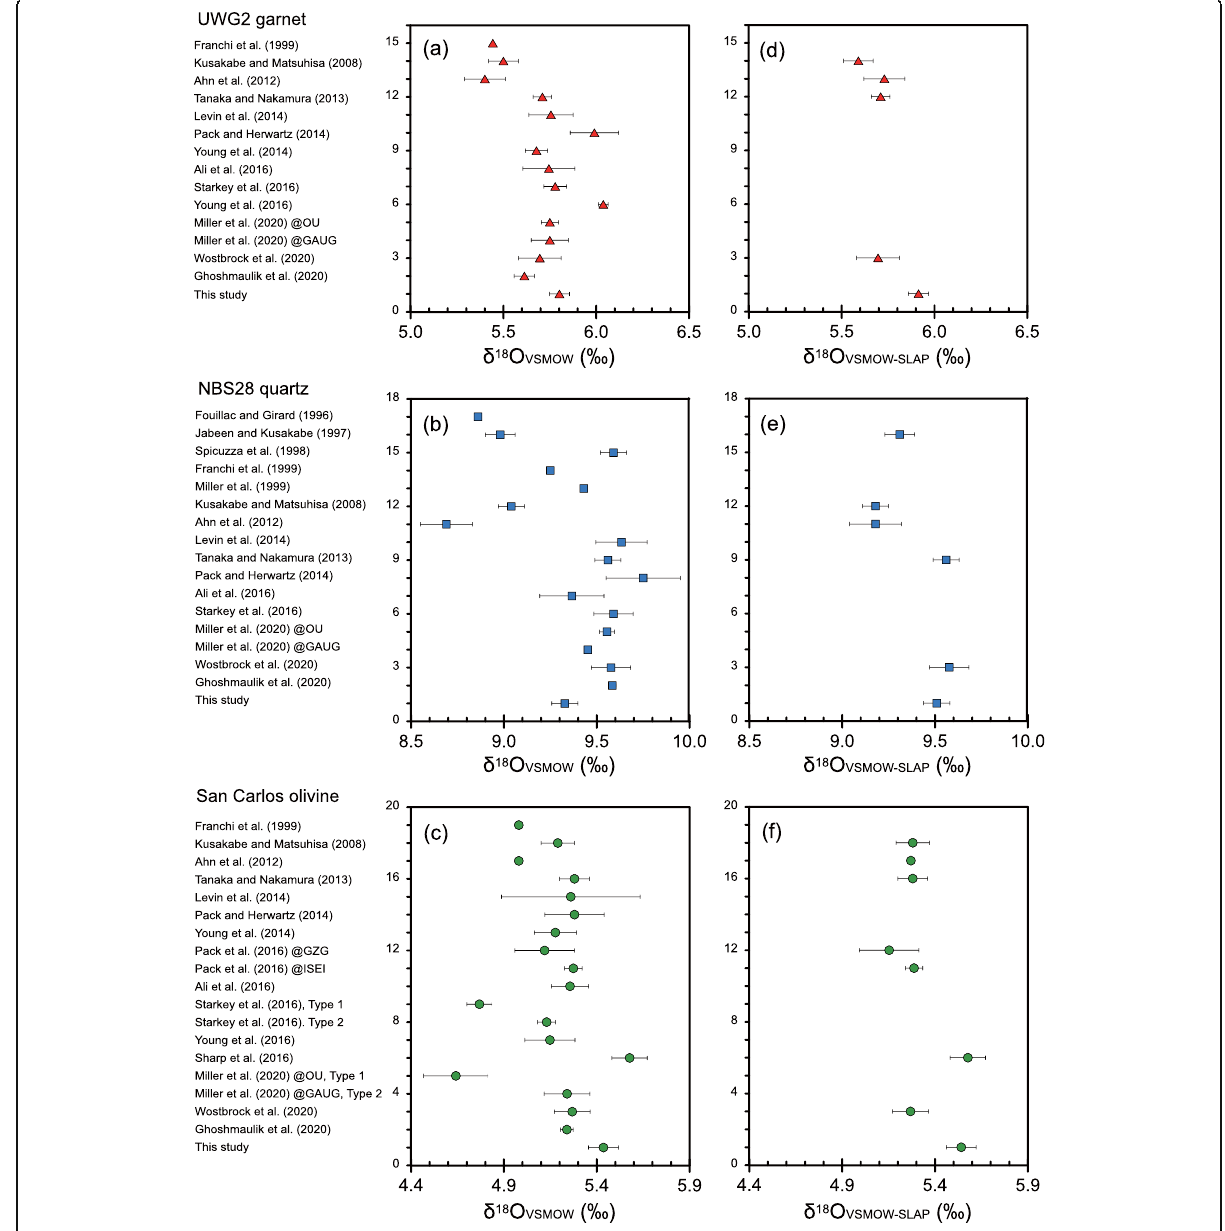
Fig. 3 Comparison of published δ 18 O values relative to VSMOW ( a – c ) and VSMOW-SLAP ( e – f ) for international silicate